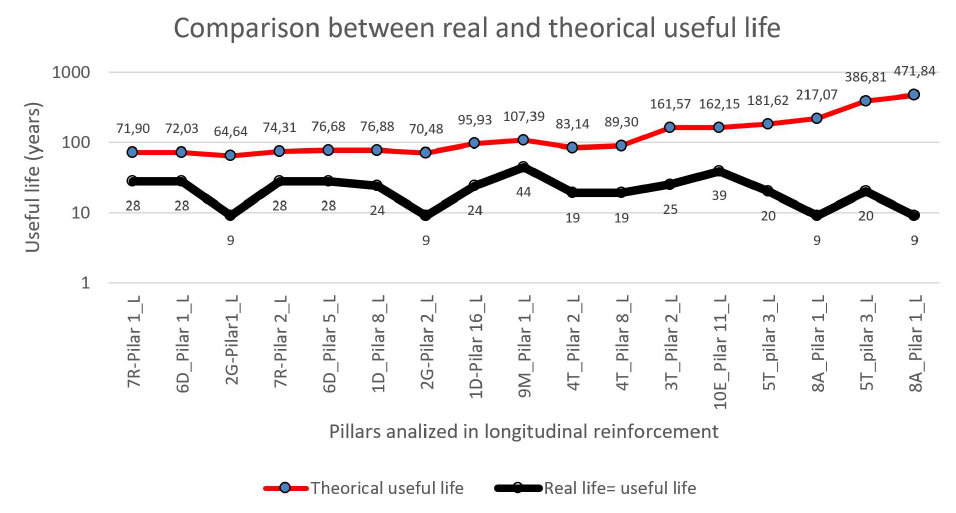
Figure 14. Relation between real and theoretical useful